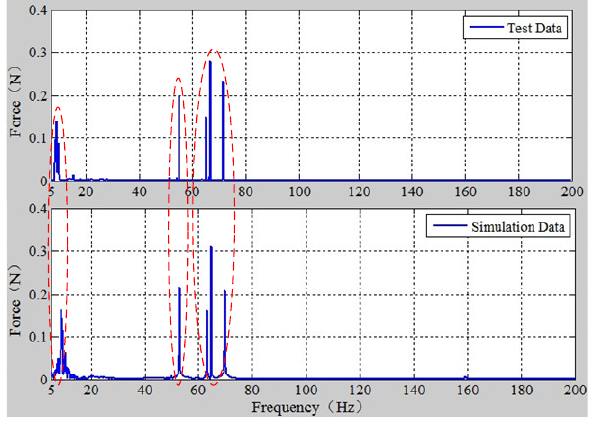
Figure 11. Test and simulation data comparison of Z-direction reaction force at O3 point.